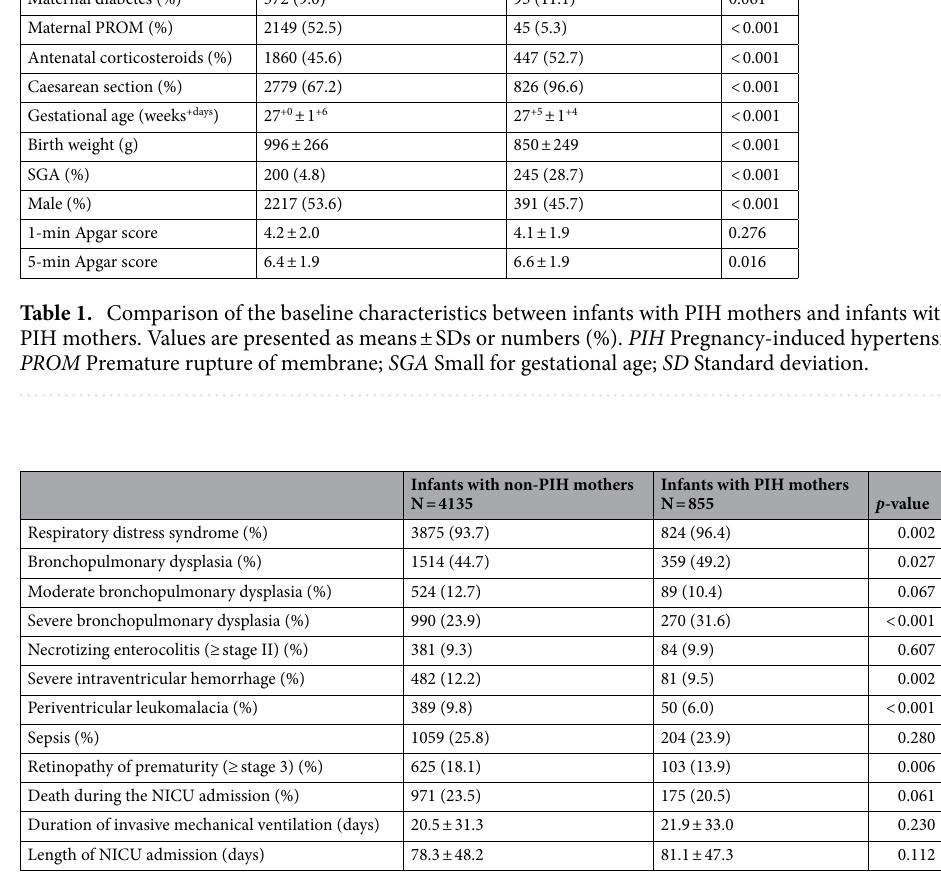
Table 2. Comparison of neonatal mortality and morbidities between infants with PIH mothers and non-PIH mothers. Values are presented as means ± SDs or numbers (%). PIH Pregnancy-induced hypertension; NICU Neonatal intensive care unit; SD Standard deviation.